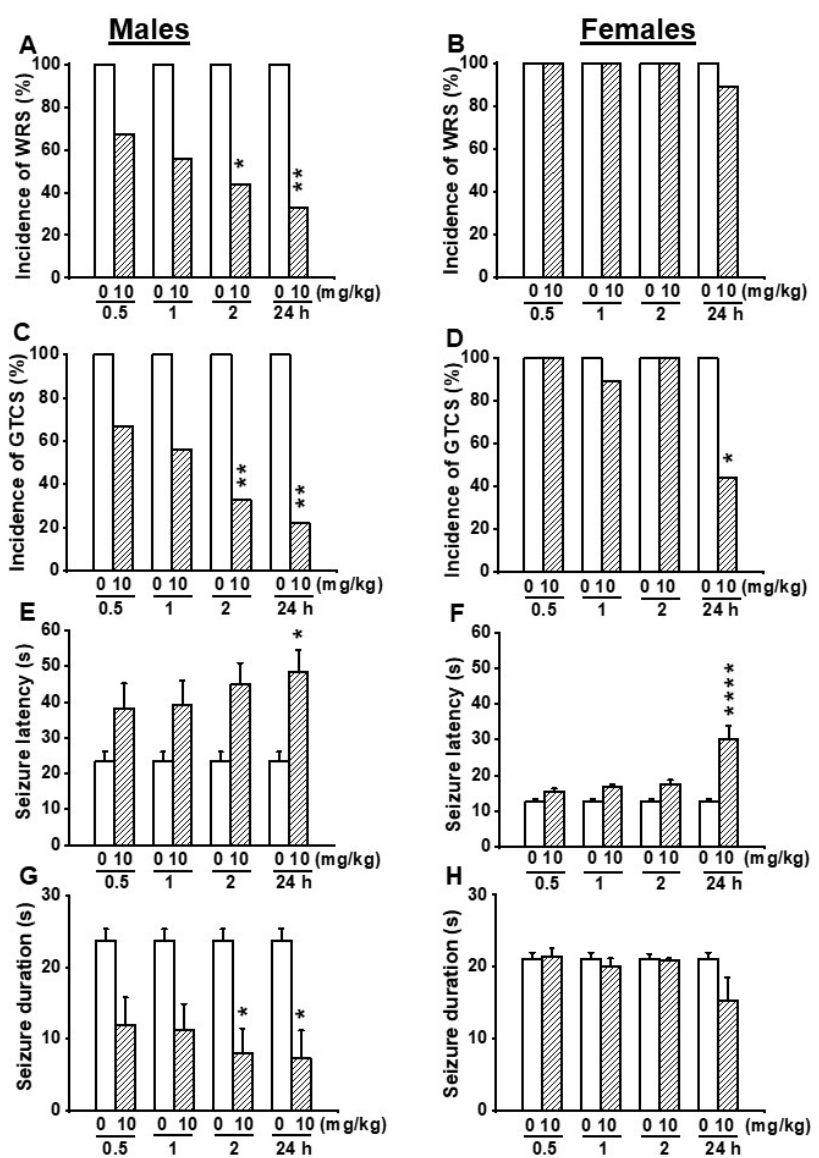
Figure 4. Effects of acute EACT treatment at the dose of 10 mg/kg on acoustically evoked seizures. The effects of EACT, a potent activator of TMEM16A, were evaluated at different post-treatment time points of 0.5, 1 h, 2 h, and 24 h in adult male and female GEPR-3s. ( A ) EACT treatment significantly reduced the incidence of the occurrence of WRSs at 2 and 24 h time points in males. ( B ) However, EACT treatment did not considerably alter the incidence of the occurrence of WRSs in